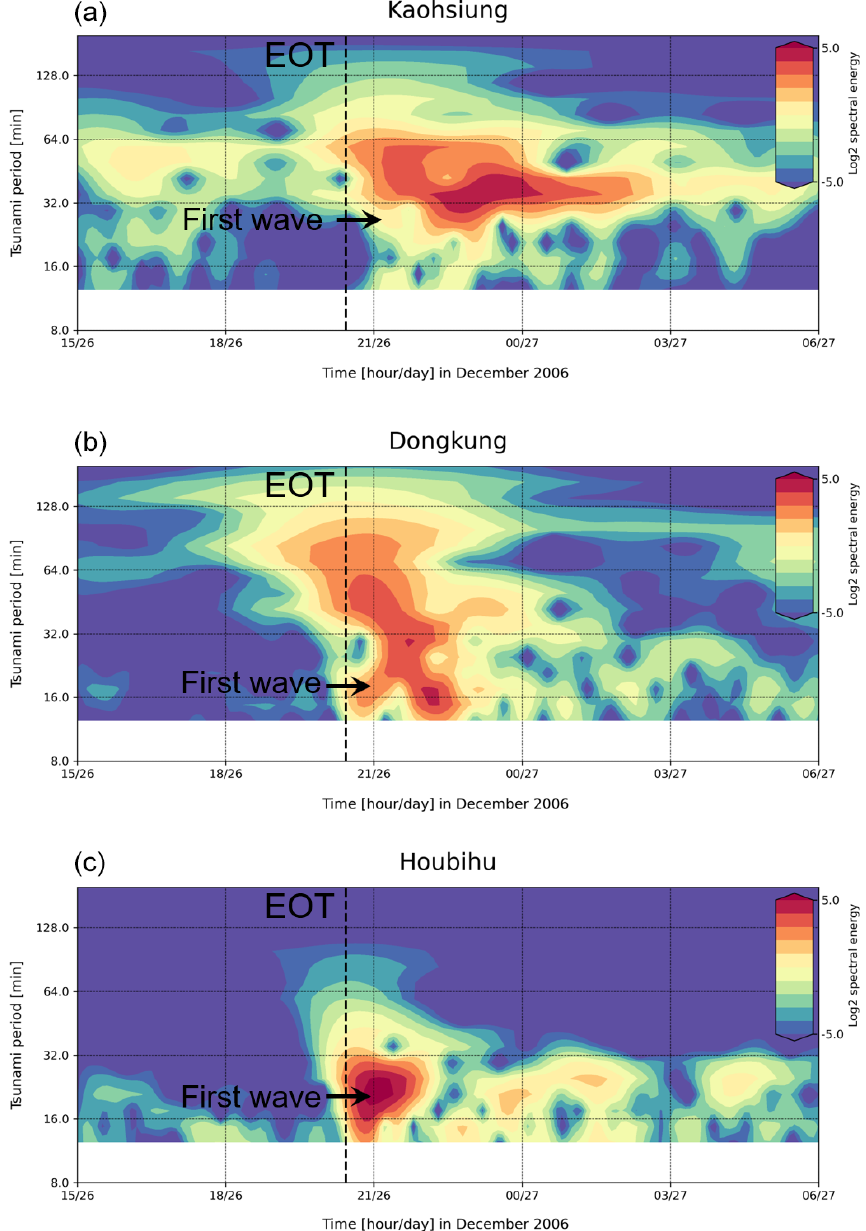
Figure 13. Wavelet (time–frequency) diagrams of tsunami data for the 26 December 2006 tsunami event at the (a) Kaohsiung, (b) Dongkung, and (c) Houbihu tide gauge stations. The color map represents the log2 spectral energy at various times and tsunami periods. The vertical, dashed black lines indicate the earthquake occurrence time (EOT). The black arrows denote the arrival time of the first tsunami wave at each